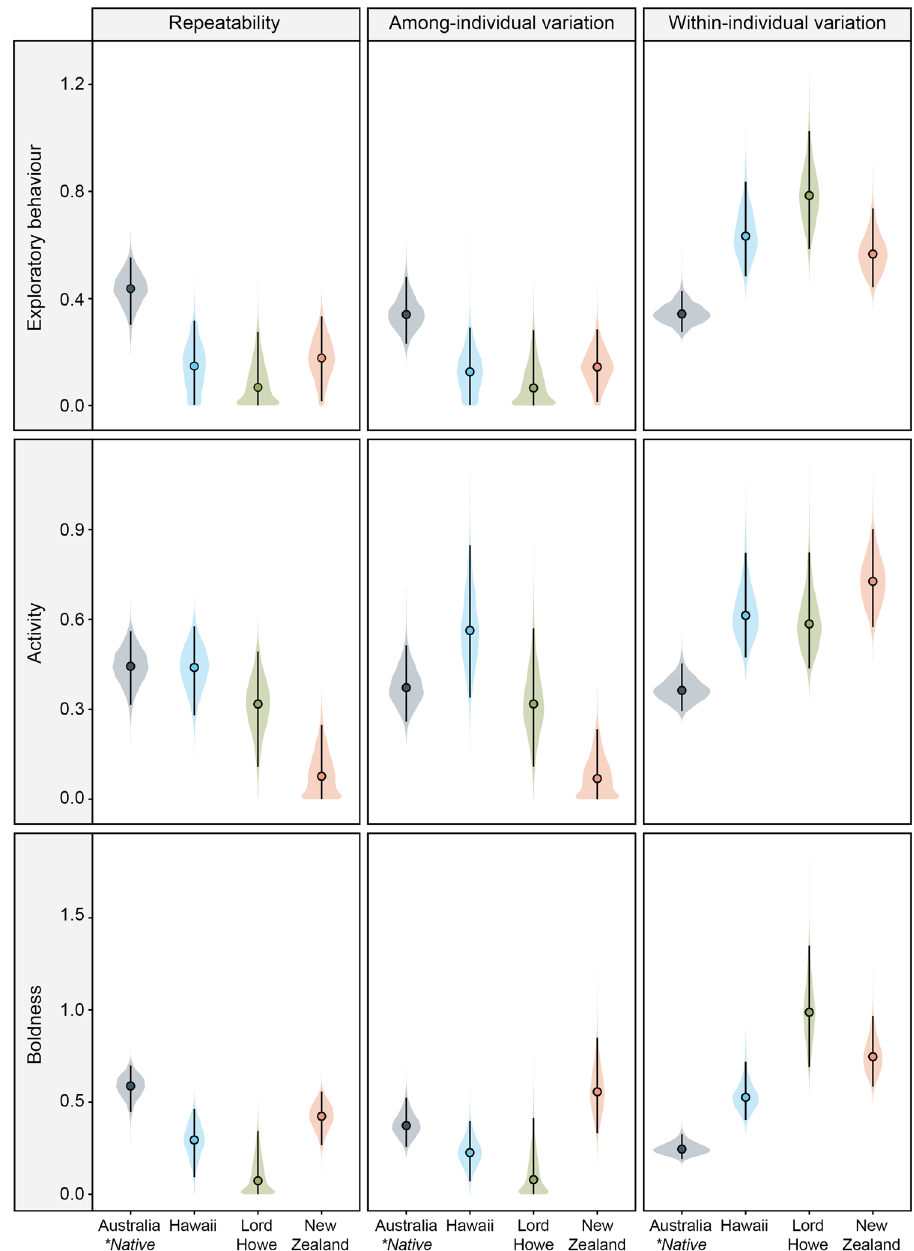
(blue; n =118), Lord Howe Island (green; n =92), and New Zealand (pink; n =143). For each graph, fi lled circles represent the median variance/repeatability estimates extracted from linear mixed-effects models, vertical error bars denote 95% credible intervals, and plot width represents probability density. Source data are provided as a Source Data fi